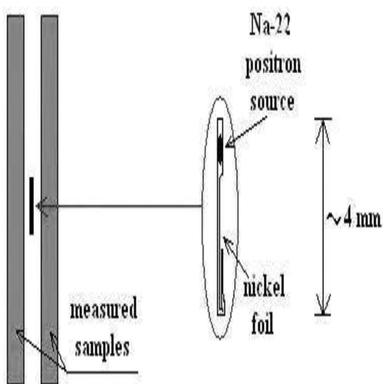
Sketch of the source-sample sandwich geometry including a blow-up of the cross section of the Na-22 positron source in Ni foil.